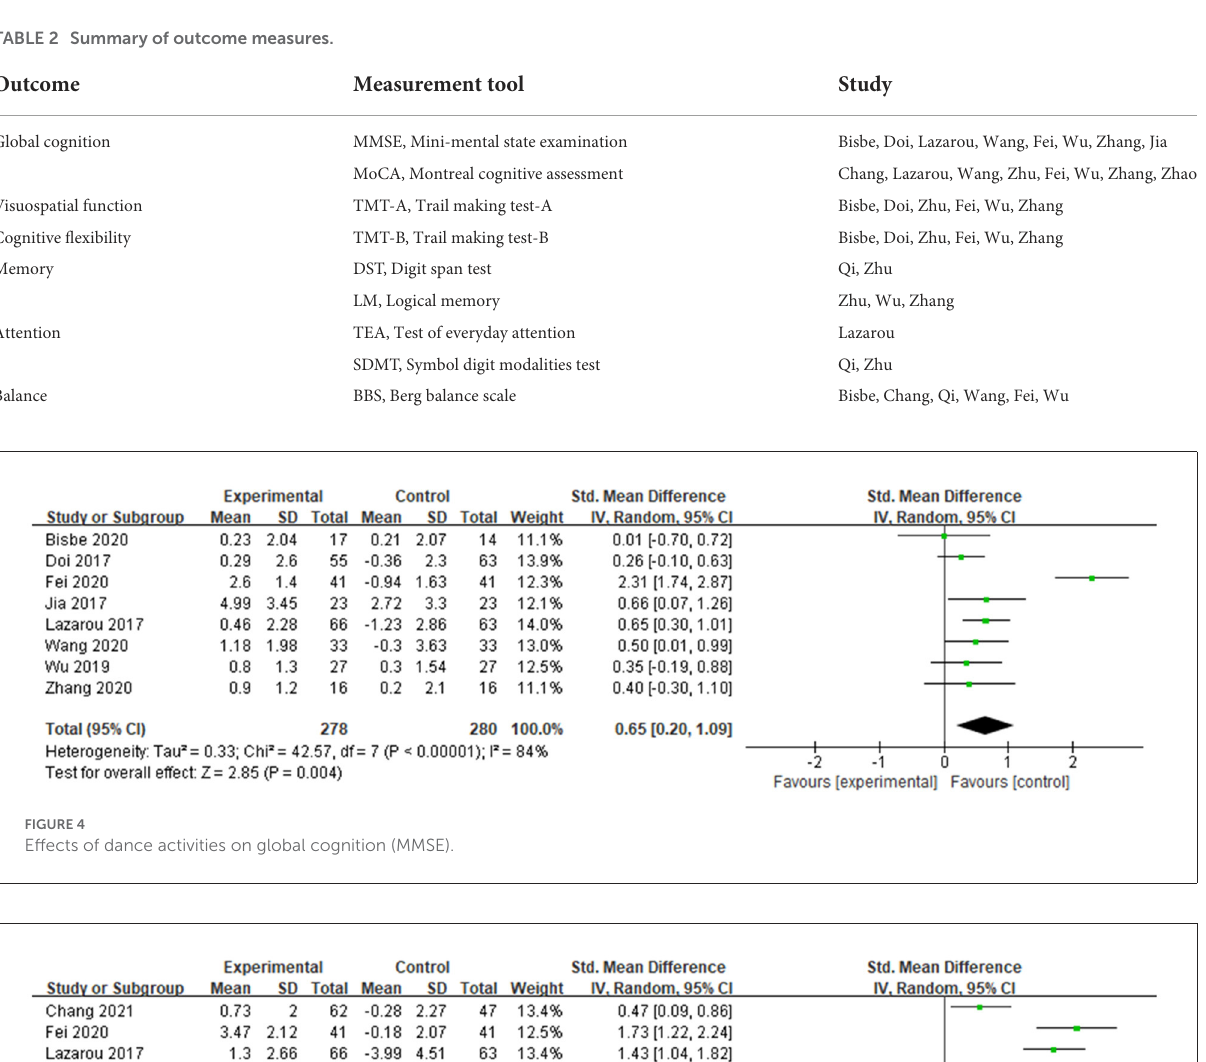
TABLE 2 Summary of outcome measures.